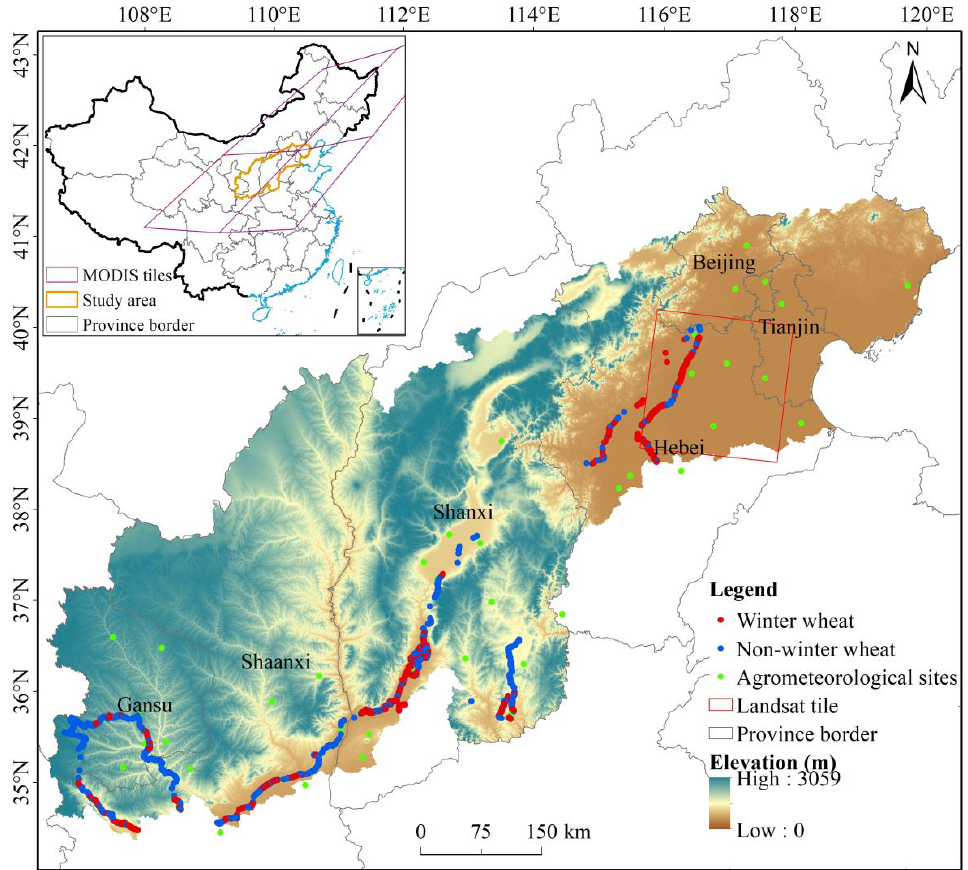
Figure 1. Geographic location of the study area. The borders of the MODIS and Landsat scenes are shown on the map. The spatial distribution of ground survey sites and the locations of agrometeorological sites are also indicated. Elevation information was derived from a digital elevation model with 90-m spatial resolution.